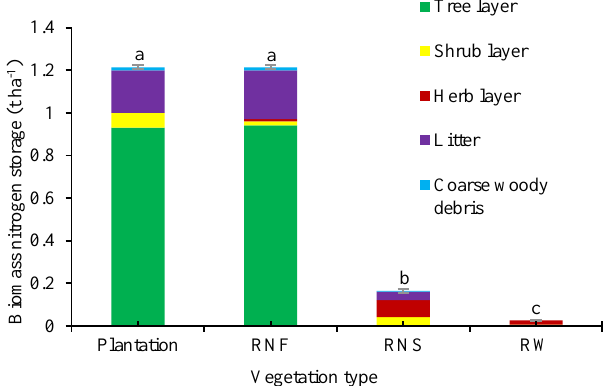
Figure 3. Biomass nitrogen stocks of different vegetation types. Note: Plantation: 30-year-old plantation; RNF: reference natural forest; RNS: reference natural recovery shrub grassland; RW: adjacent reference wasteland. Data are means ± stand deviation, with the same letters among stands denote insignificant differences ( p = 0.05).